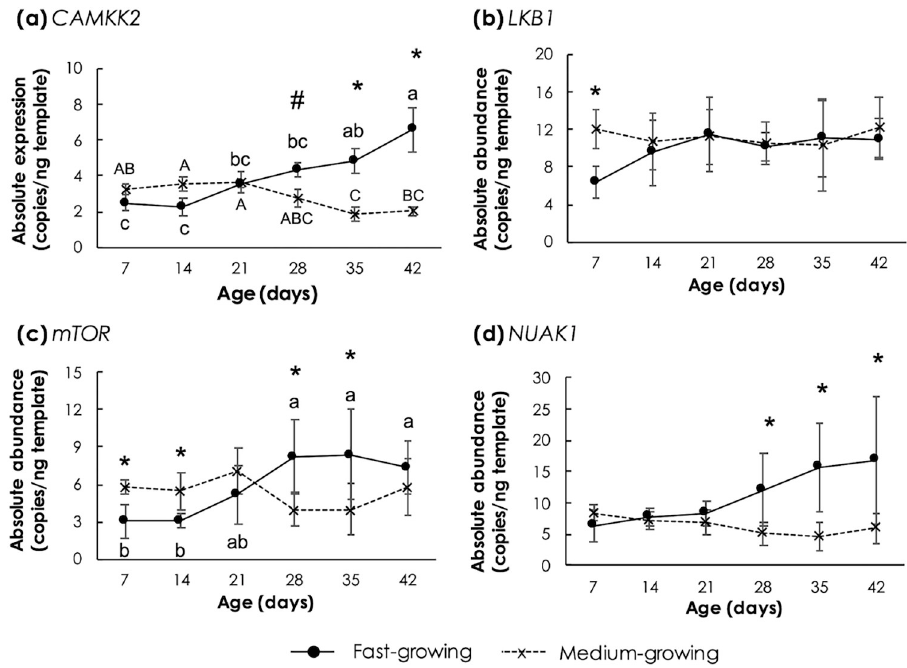
Fig 5. Absolute transcript abundance of genes encoding upstream and downstream kinases of 5’-adenosine monophosphate-activated protein kinase (AMPK) in Pectoralis major muscle of fast- and medium-growing chickens at different ages. The genes include (a) Ca 2+/ calmodulin dependent protein kinase kinase beta ( CAMKK2 ), (b) liver kinase 1 ( LKB1 ), (c) mechanistic target of rapamycin ( mTOR ), and (d) novel kinase family 1 ( NUAK1 ). Markers and error bars depict mean and standard deviation (n = 5). Lower case letters indicate significant differences among fast-growing chickens. Upper-case letters indicate significant differences among medium-growing chickens. Asterisks and sharp sign indicate a significant difference between the two strains at the same age. # p < 0.1, � p < 0.05, �� p < 0.01.